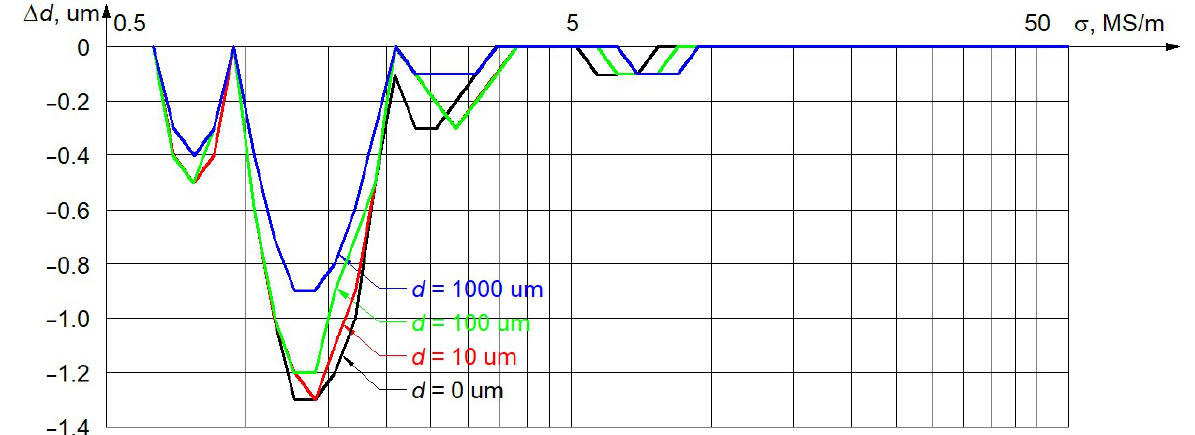
Figure 9. Dependence of the deviation of the measured value d on the value σ.